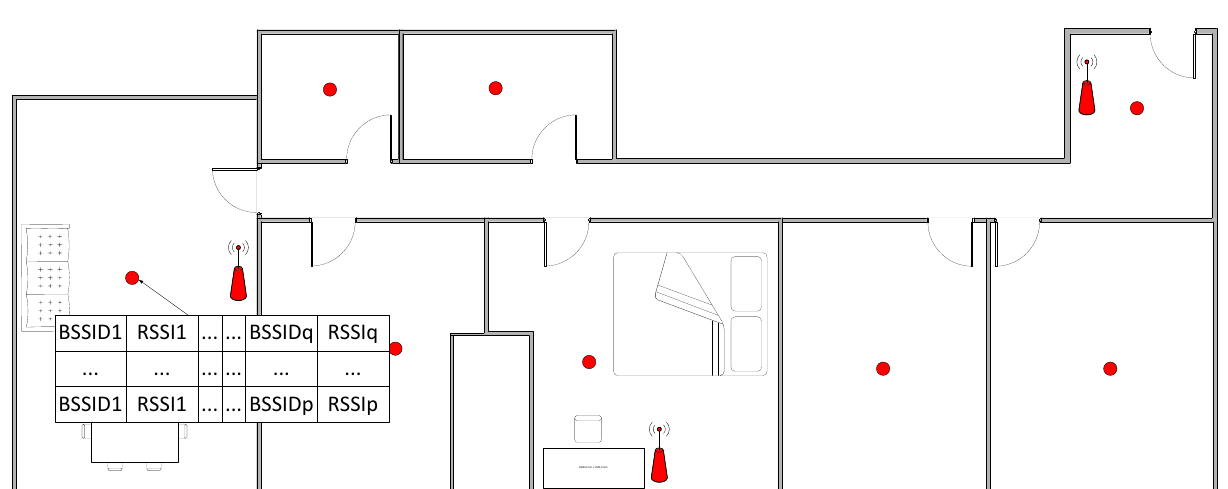
Figure 3. Calibration